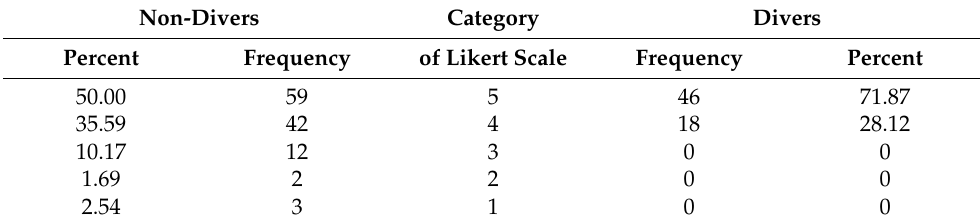
Table 3. Scuba diving impact on